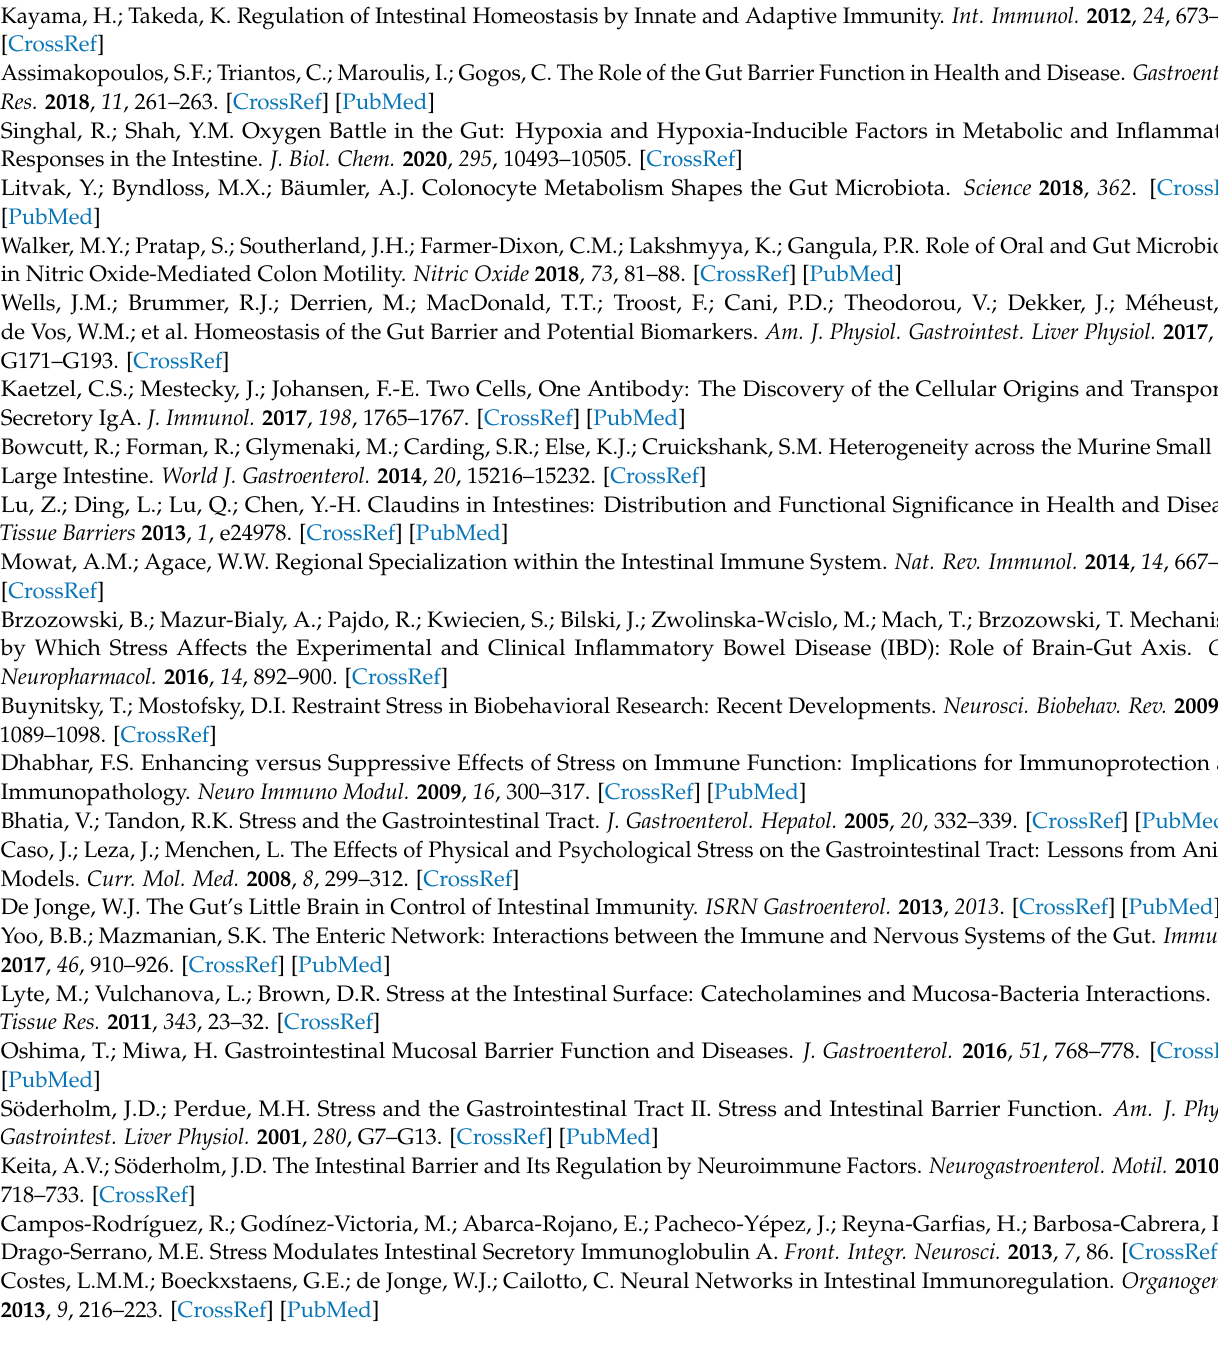
Institutional Review Board Statement: Figure 2 depicts data raised from experimental protocol in mice conducted according to the ARRIVE guidelines [88] and approved by The Comit é